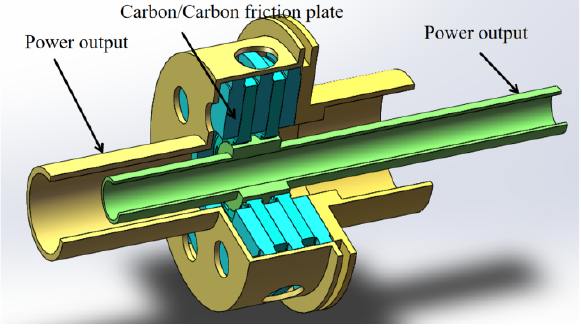
Figure 4. 3D simpli fi ed model of the clutch. Figure 4. 3D simplified model of the